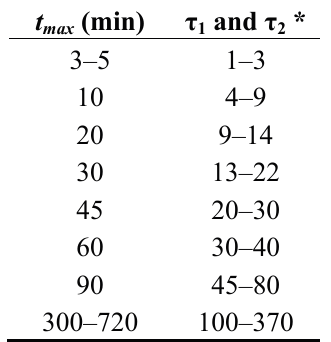
Table 2. Selection rules for the initial values of τ